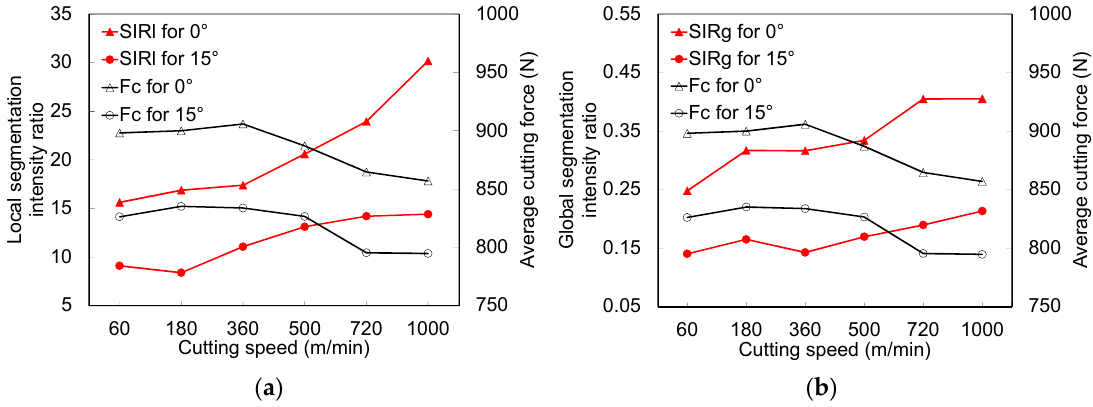
Figure 11. Correlation between average cutting force and segmentation intensity ratio: ( a ) SIR ( b ) SIR g